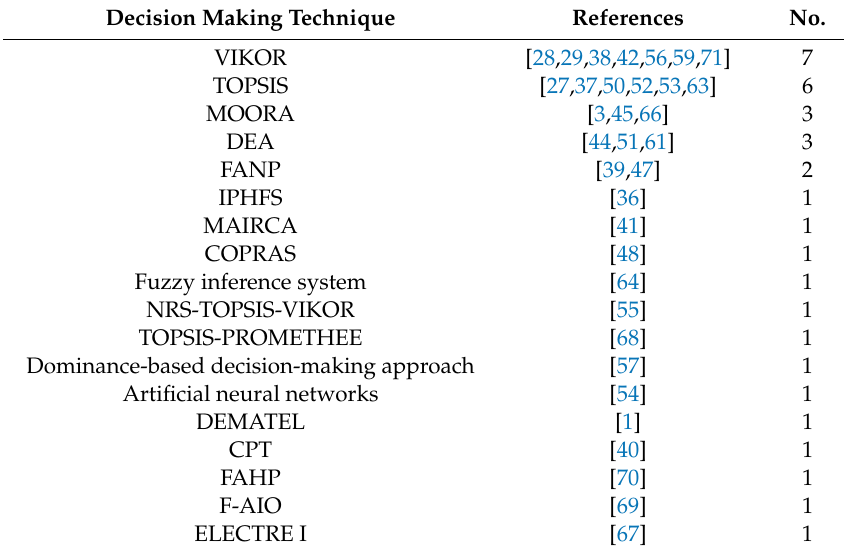
Table 8. Decision making